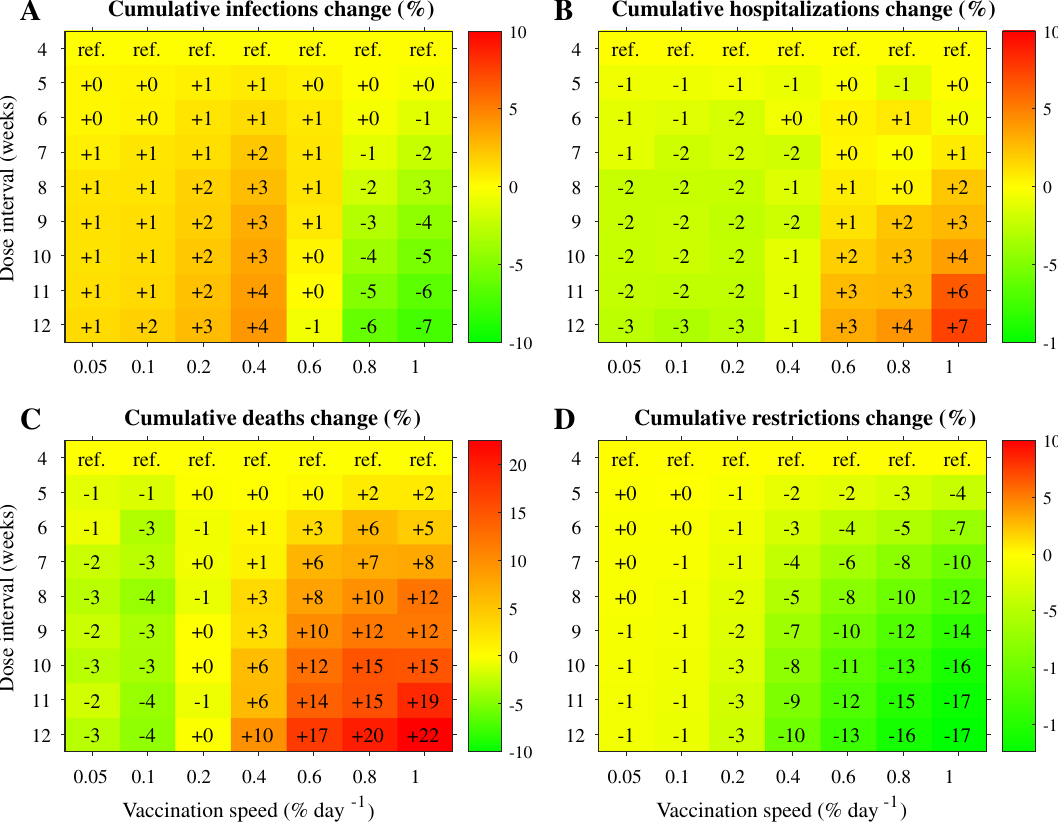
Figure 5. Heatmaps showing the impact of dose intervals and vaccination speed on ( A ) infections, ( B ) hospital admissions, ( C ) mortality, ( D ) and the AUC of non-pharmaceutical public health restrictions, when using the Oxford/AstraZeneca vaccine efficacy data. A 4-week dose interval was used as a reference, and all changes are given as percentages with respect to the reference scenario. Default parameters are gathered in Table 1 of Appendix